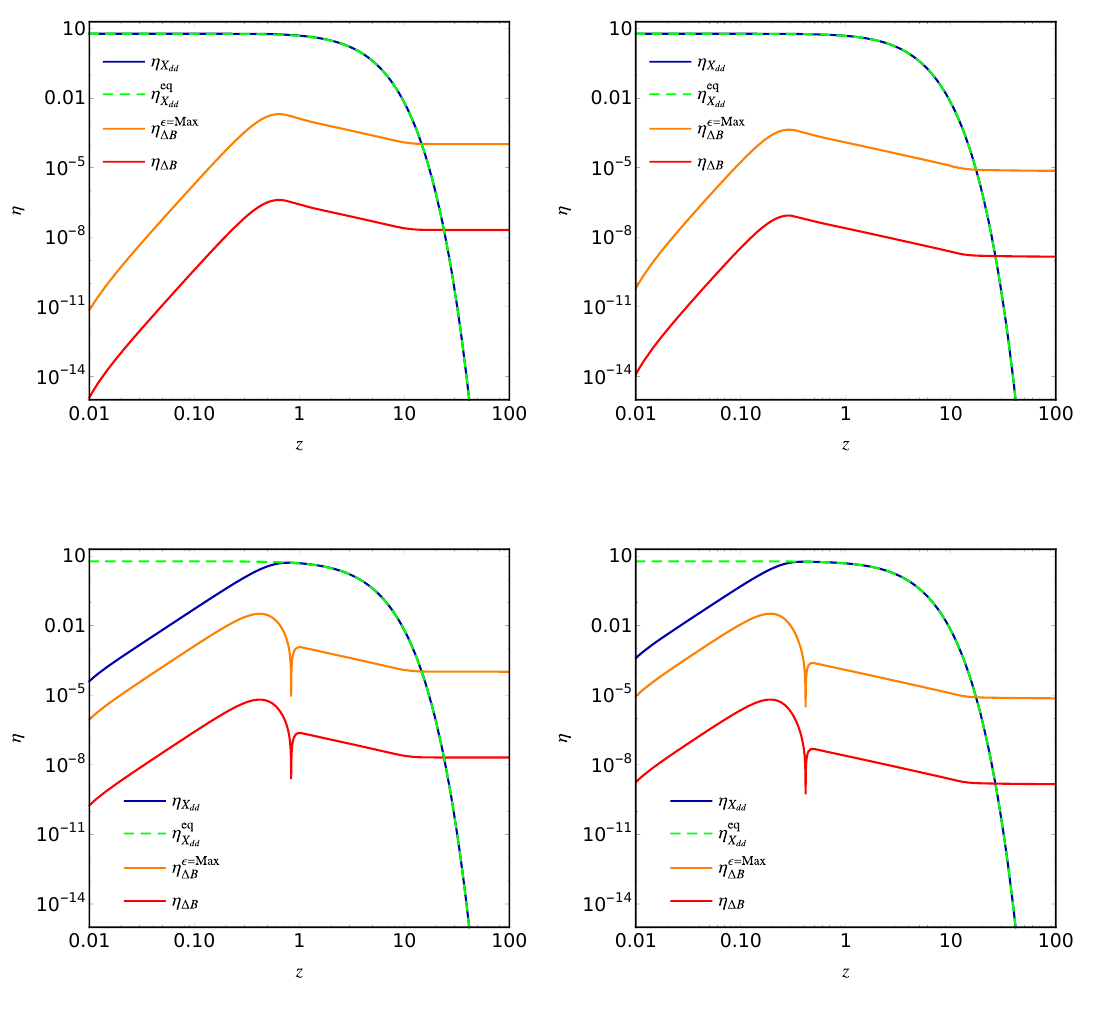
Figure 15 . High-scale scenario. Evolution of baryon asymmetry η ∆ B with respect to z = m X /T dd with f = f = 0 . 05 , λv 0 = 1 . 5 m , and m = 5 TeV, for both the maximal value of (cid:15) (orange ud dd X dd X ud line) and the value (cid:15) ≈ 4 . 0 × 10 − 4 given by eq. (5.1) with x = 0 . 2 (red line). The blue line shows the number density of X (normalised to the photon number density) and the dashed green line shows dd the equilibrium number density of X . Top row: number density evolution with X starting in dd dd equilibrium. Bottom row: no initial abundance of X . Left column: m = 10 14 GeV . Right dd X dd = 10 13 column: m X ud